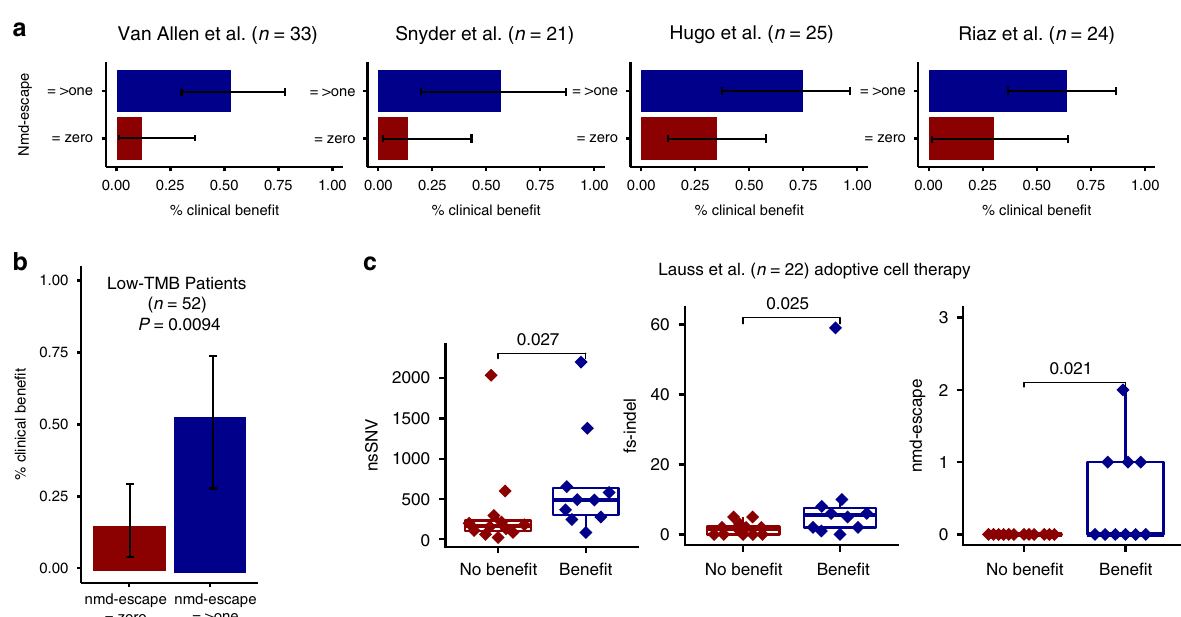
Fig. 4 NMD-escape mutations predict CPI response in low-TMB patients and response to ACT. a Shows the percentage of patient with clinical bene fi t from CPI therapy, for patients with ≥ 1 NMD-escape mutation (dark blue) and zero NMD-escape mutations (dark red), error bars denote 95% con fi dence intervals of the percentage clinical bene fi t estimates. Sample sizes are listed on the fi gure and represent number of patients. b Shows the combined set of CPI treated patients (across all four studies) split to make a low-TMB cohort (nsSNV count < 217, the median value across all cohorts, approximately equivalent to 10 mutations/Mb). The total patient number is n = 52. The percentage clinical bene fi t rates are shown for patients with zero and ≥ one NMD- escape mutation, error bars denote 95% con fi dence interval and signi fi cance determined using Fisher ’ s exact test. c Shows non-synonymous SNV count, frameshift indel count and NMD-escape mutation count, compared in an adoptive cell therapy treated cohort of n = 22 patients. In all boxplots in this fi gure the centre line is the median, the bounds of the box represent the inter-quartile range, the lower whisker = max(min(x), Q_1 − 1.5 × IQR) and upper whisker = min(max(x), Q_3 + 1.5 × IQR). Two-sided Mann – Whitney U test was used to assess for a difference between groups.